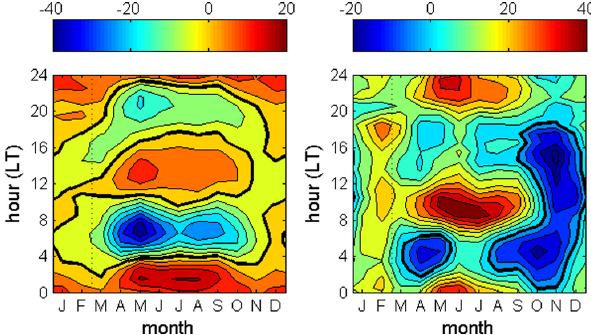
Fig. 6. Hourly mean meridional (left panel) and zonal (right panel) winds. Contours are spaced at 5ms − 1 intervals and the thick black contour is the zero wind